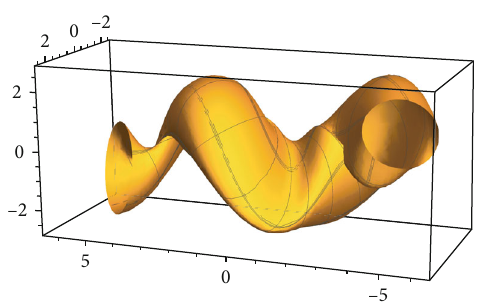
Figure 3: Tubular surface Ω